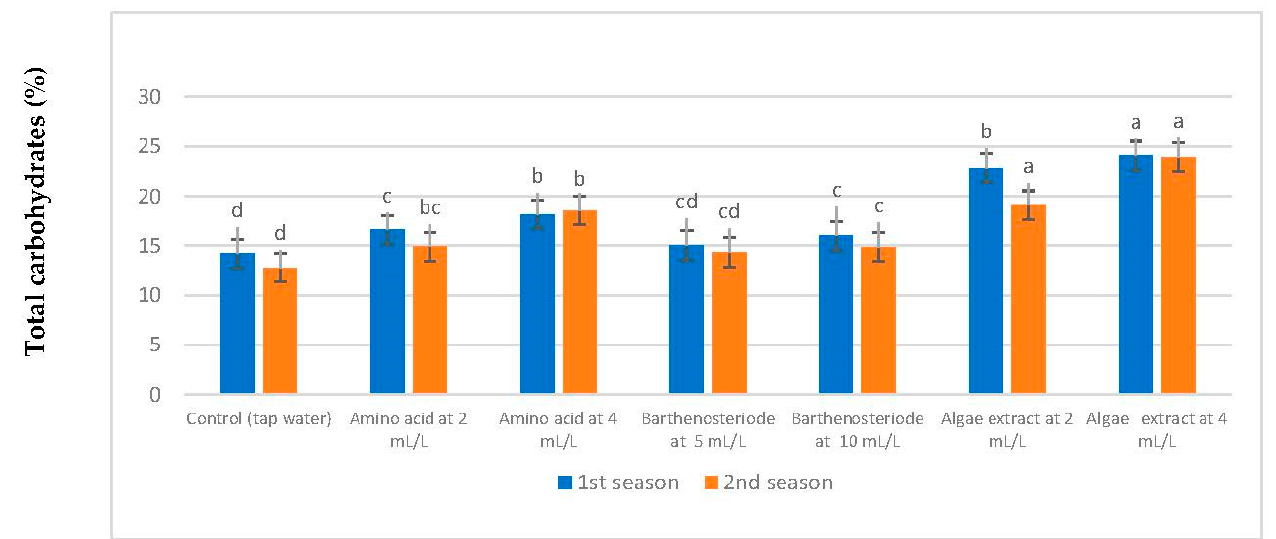
Figure 7. Effect of various bio-stimulants treatment on total carbohydrates (%) of chia ( Salvia hispanica L.) plants during the 2019–2020 and 2020–2021 seasons. For the same column, means followed by the same letter are not statistically different, according to the Tukey multiple range test.